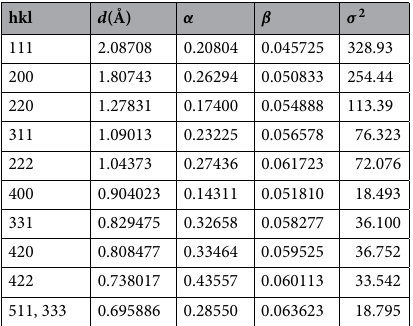
Table 4. Instrument broadening parameters as evaluated with a Cu calibration